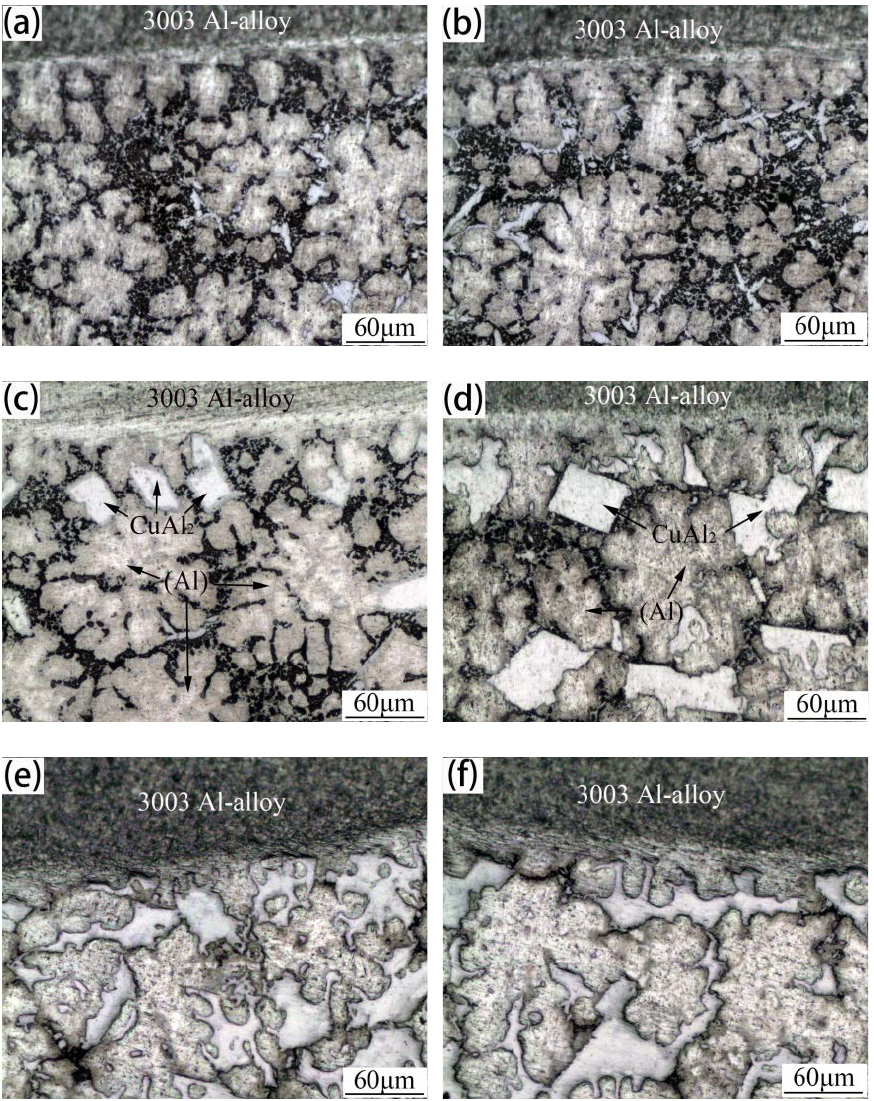
Figure 7. Microstructures of Al/brazing seam interfaces of 3003 Al/Cu joints brazed by ( a ) Zn-2Al; ( b ) Zn-5Al; ( c ) Zn-12Al; ( d ) Zn-15Al; ( e ) Zn-20Al; and ( f ) Zn-25Al.